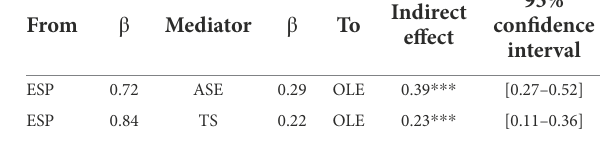
TABLE 4 Summary of mediation analysis.